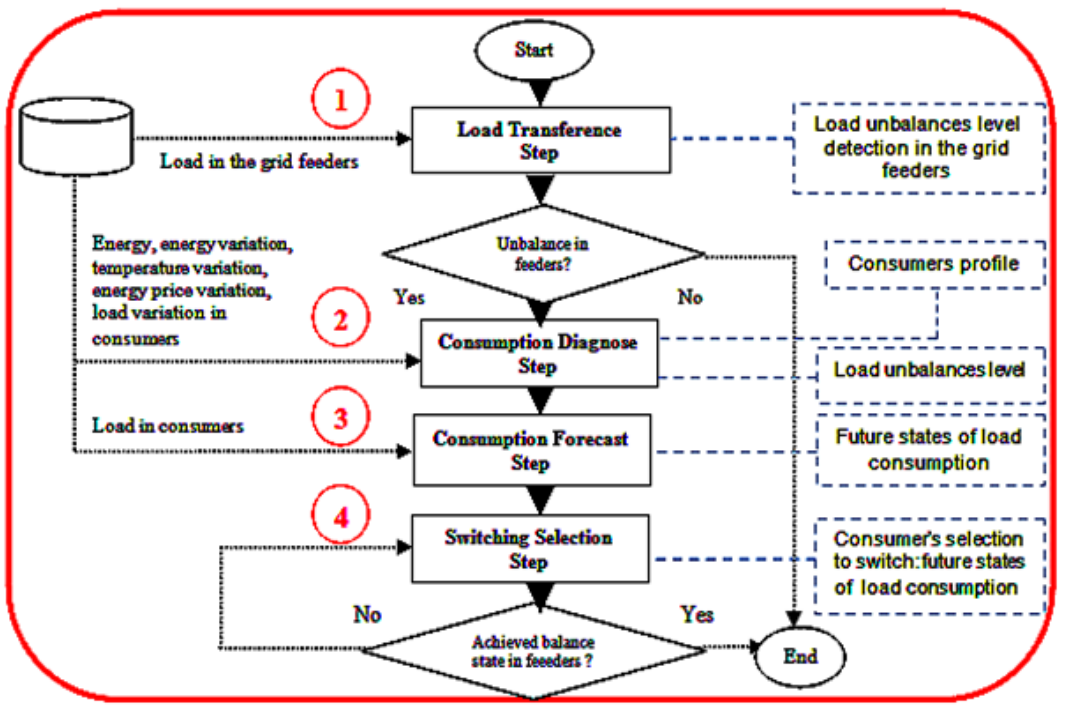
Figure 4. LBC system high-level